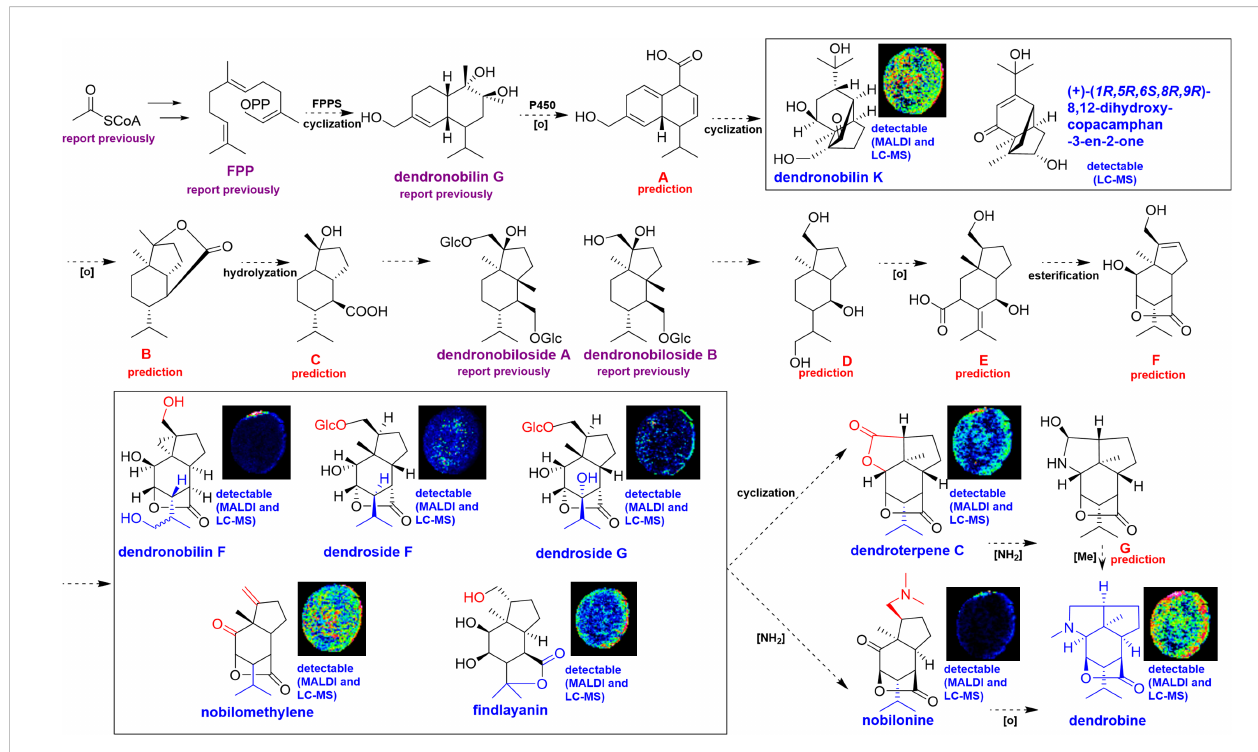
FIGURE 7 Proposed metabolic pathway for the biosynthesis of dendrobine in mature Dendrobium nobile stem based on the integrating analysis from UPLC-QTOF- MS and MALDI-MSI. (A-G) are the predicted skeleton of proposed